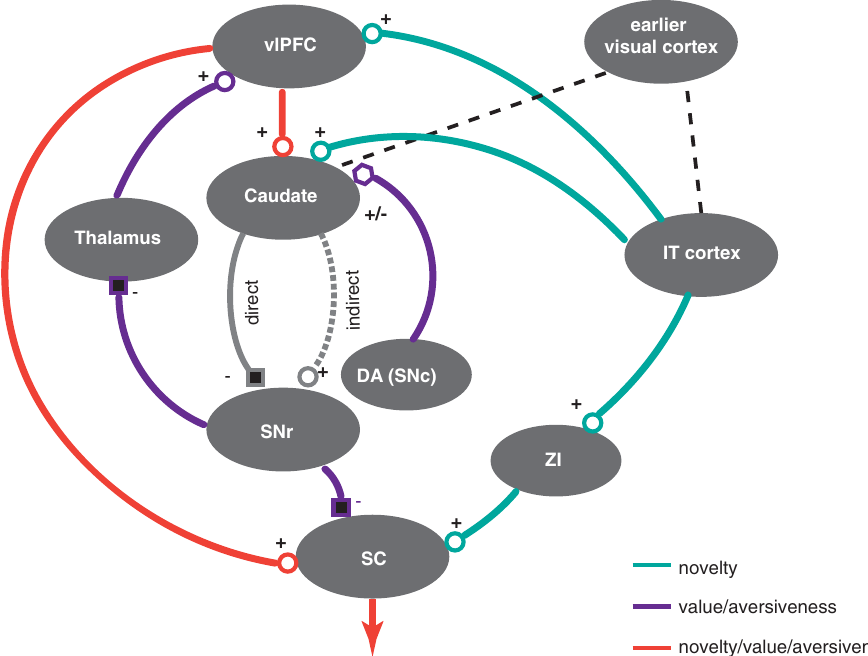
Fig. 7 | Circuit model summary of salience memory fl ow across cortex, basal ganglia and thalamus. The connectivity between prefrontal cortex, temporal cortex, basal ganglia and thalamus along with projection signs represented by shape of terminal are shown (circle: excitatory, square: inhibitory or pentagon: modulatory). Connections are color coded by the presumed type of information they carry (value, aversiveness and novelty). Direct and indirect pathways inside basal ganglia are noted as grey connections. Dopamine neurons residing in the